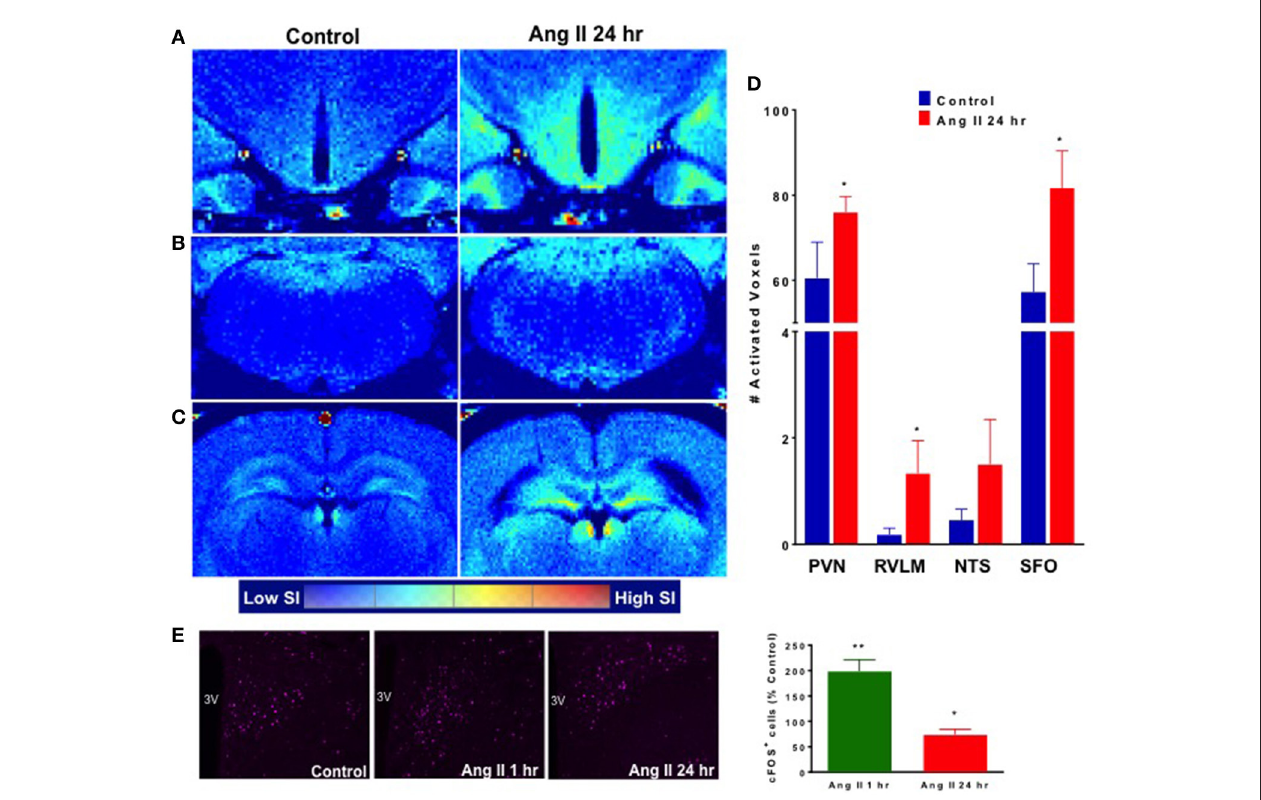
FIGURE 5 | Effect of systemic Ang II injection on cardioregulatory brain regions. Manganese-labeled hypothalamic (A) , brainstem (B) and circumventricular (C) activity following control injection (left) and 24 h following Ang II injection (right). (D) Quantification of activated voxels in the PVN, RVLM, NTS and SFO, 24 h following Ang II injection (red bars). (E) Quantification of Fos expression in the PVN (purple) at 1 and 24 h following Ang II injection. ± SEM. N = 4–6 per group, Unpaired Student Ttest was used in D and E. ** p < 0.01, * p < 0.05 vs.